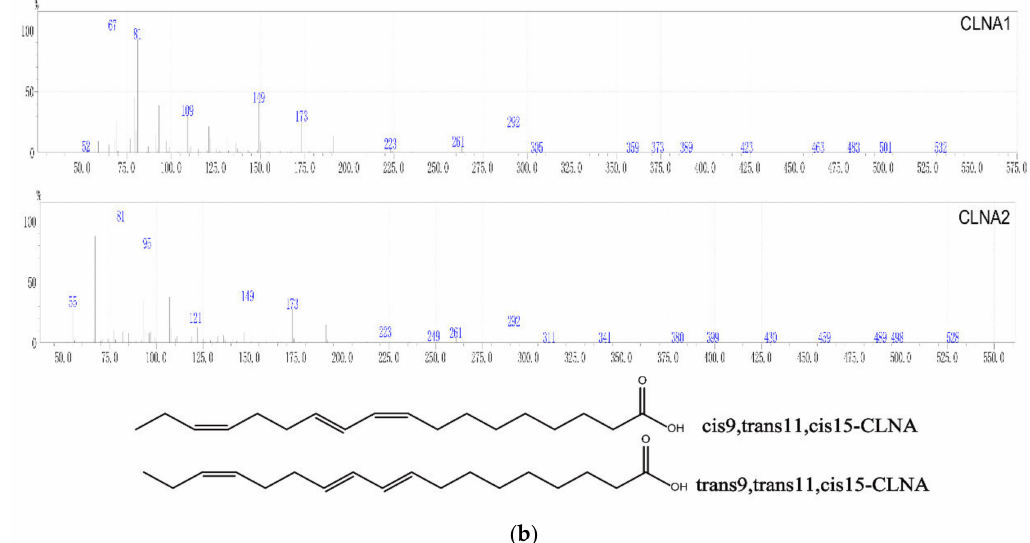
Figure 2. Preparation and purity detection of CLNA1 and CLNA2. ( a ) Separation of CLNA1 and CLNA2 by liquid chromatograph. The purity of CLNA1 and CLNA2 detected by GC-MS (C17:0 was added as a standard). ( b ) Mass spectrum and chemical structures of conjugated linolenic acid (CLNA) isomers used in this study (CLNA1: c9, t11, c15-CLNA, CLNA2: t9, t11, c15-CLNA).